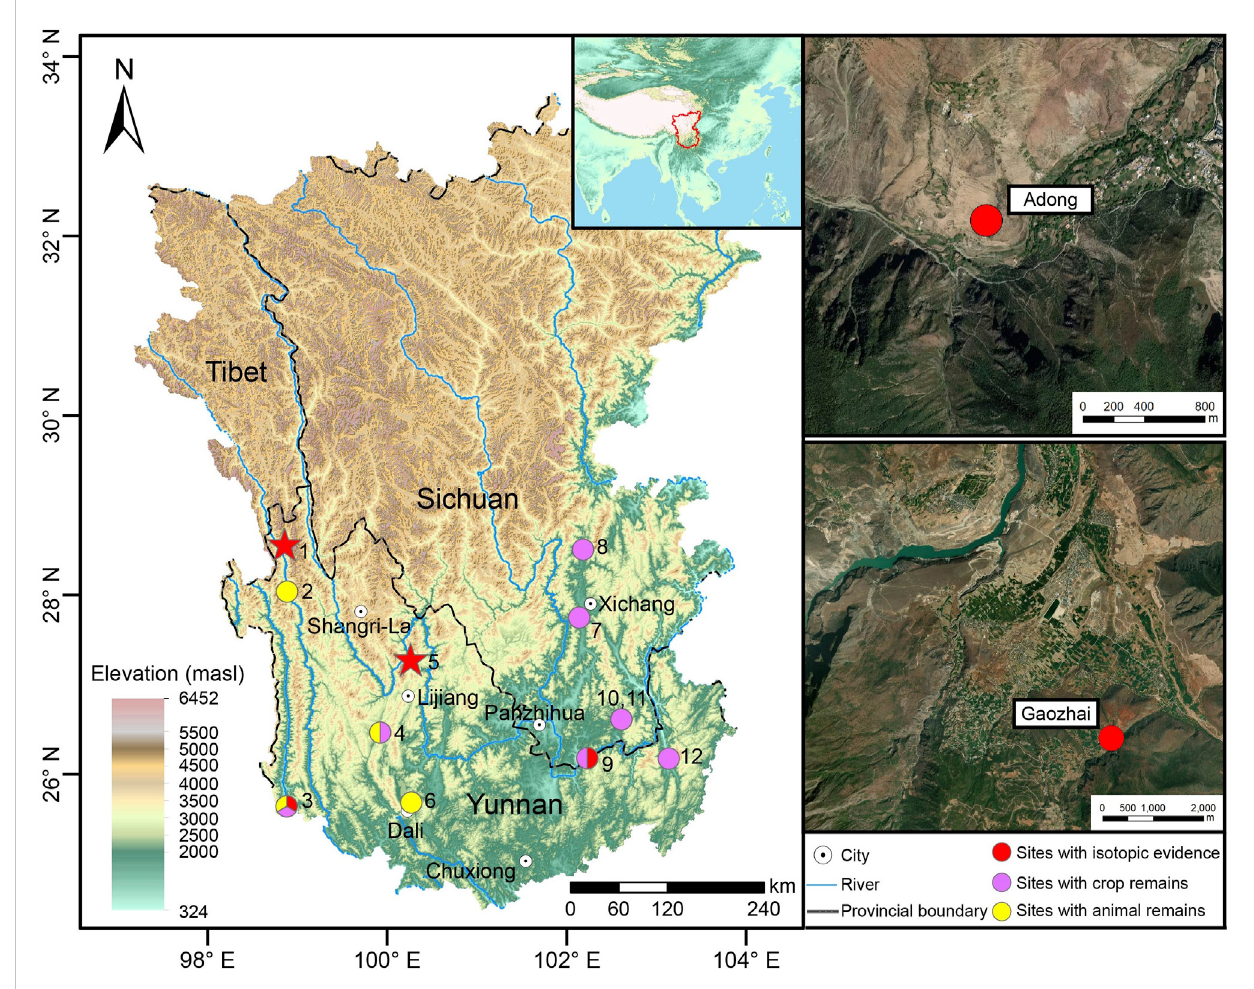
FIGURE 1 Archaeological sites with isotopic data of human bone collagen and remains of crops and animals in the HMR during the Bronze Age; (1) Adong; (2) Zongzan; (3) Shilinggang; (4) Haimenkou; (5) Gaozhai; (6) Yinsuodao; (7) Shapingzhan; (8) Gaopo; (9) Jiangxifen; (10) Dashanbao; (11) Tuanshanbao; (12)